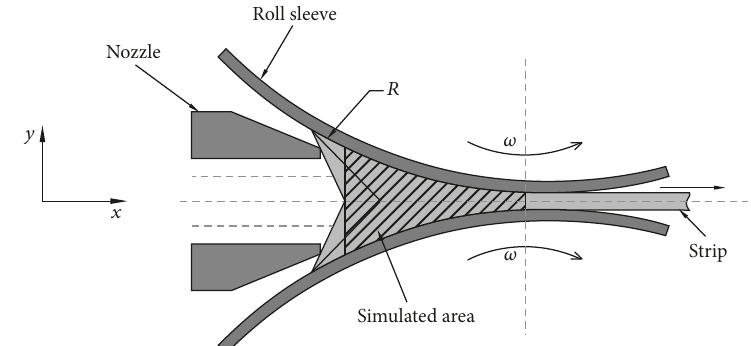
Figure 2: Diagram of the twin-roll casting